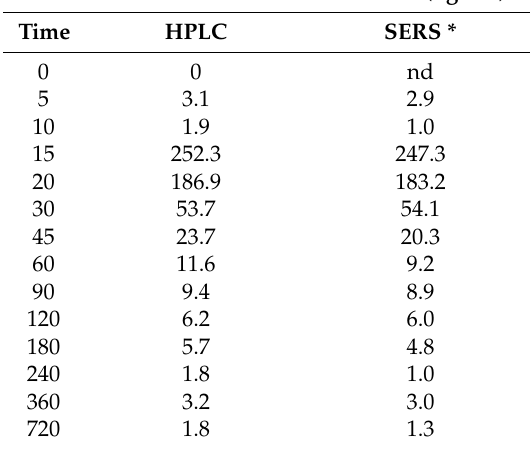
Table 3. Summary of HPLC and SERS* Analysis Results for Patient Samples, reprinted with permission from ref. [45].